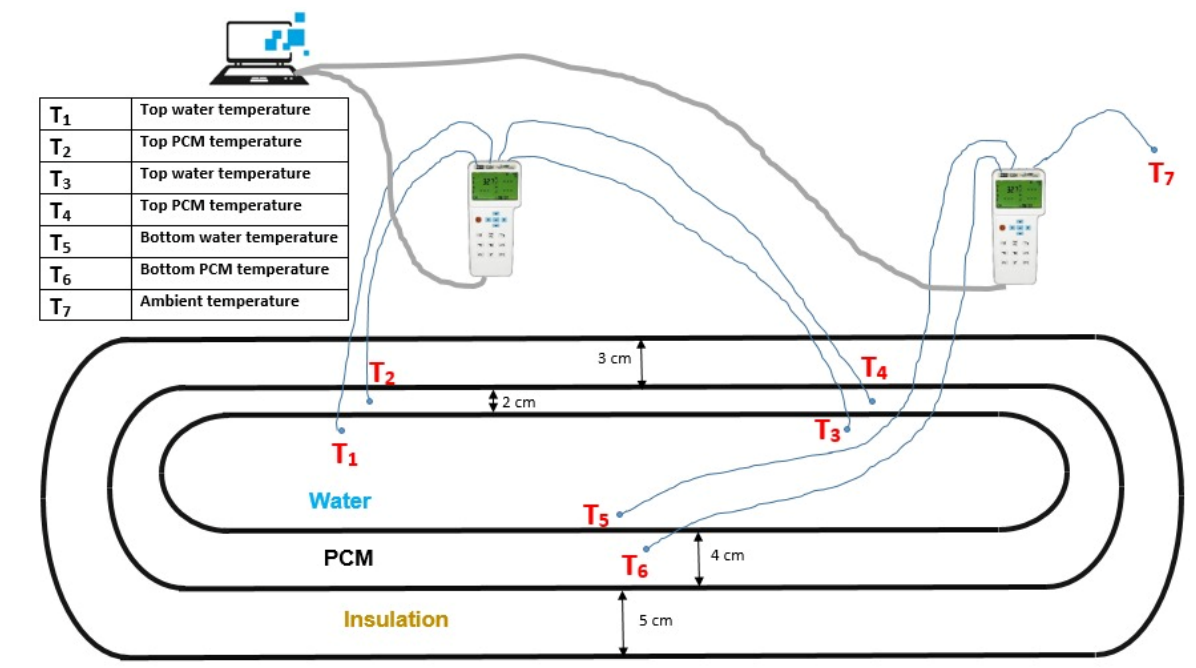
Figure 1. Schematic representation of the storage tank with instrumentation.